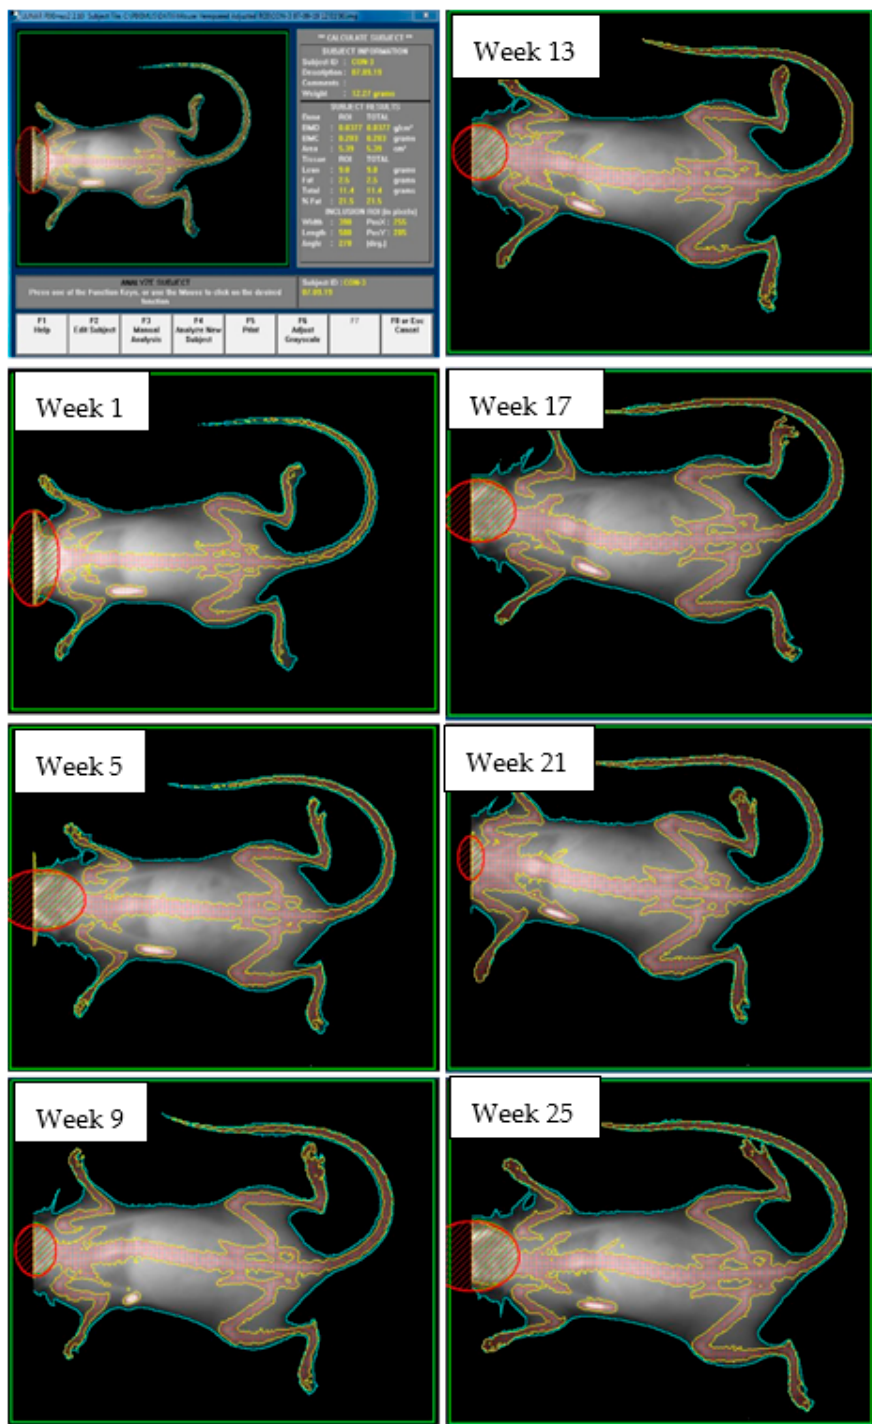
Figure 6. Representative time series of dual-energy X-ray absorptiometry images from one mouse (control group). Live mice were anesthetized and placed in the prone position for imaging. The skull was excluded from analysis. The white oval below the right forearm is an implanted identification microchip.